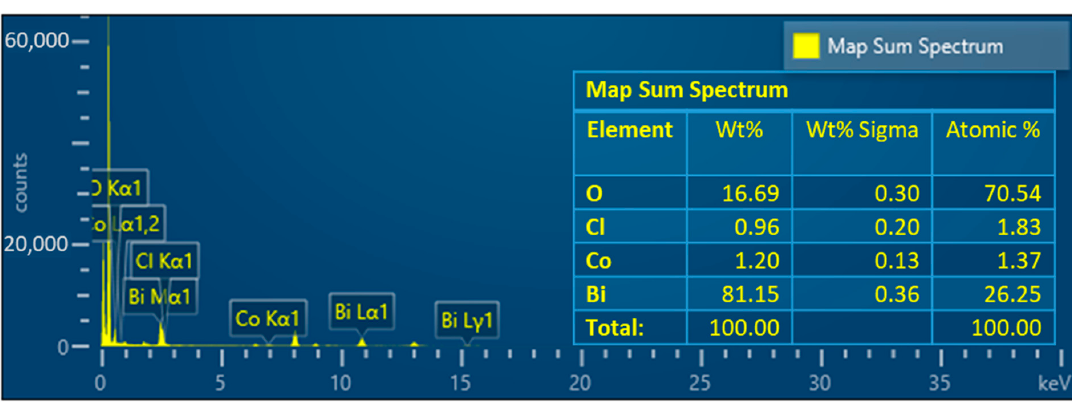
Figure A2. EDX spectrum of 20-Co 3 O 4 /BOC, and its elemental and atomic wt.% in the inset table.